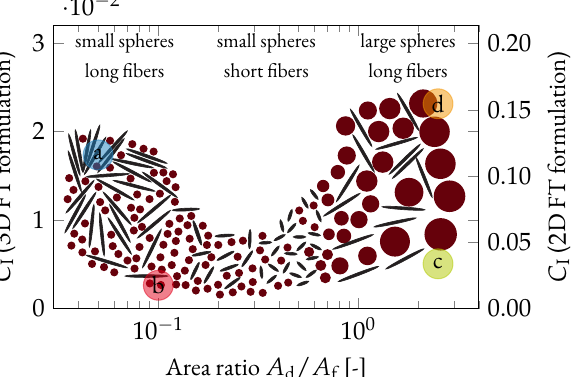
Figure 12. Generalization of Figure 9 illustrating the assumed suspension composition yielding the corresponding FT parameter. The colored points are drawn at the positions of the colored points in Figure